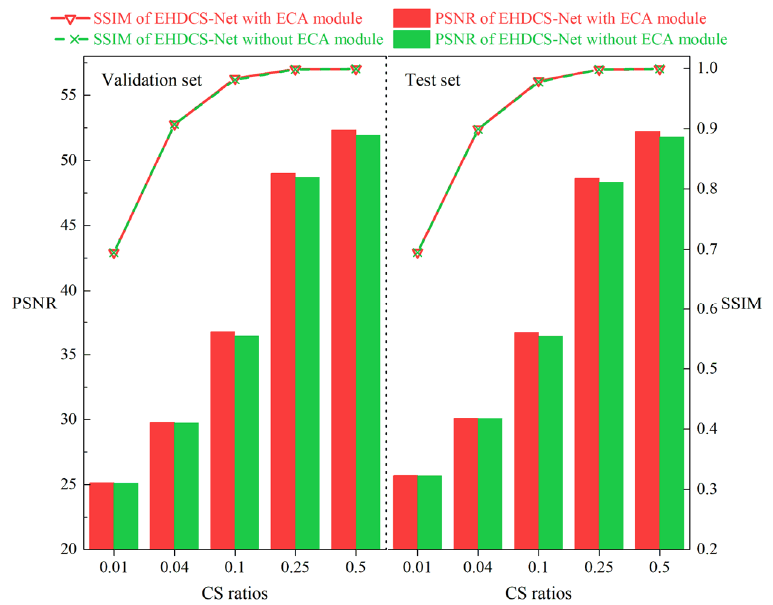
Figure 10. Comparisons of PSNR and SSIM values of EHDCS-Net with and without the ECA module on the validation and test sets, respectively, at different CS ratios.